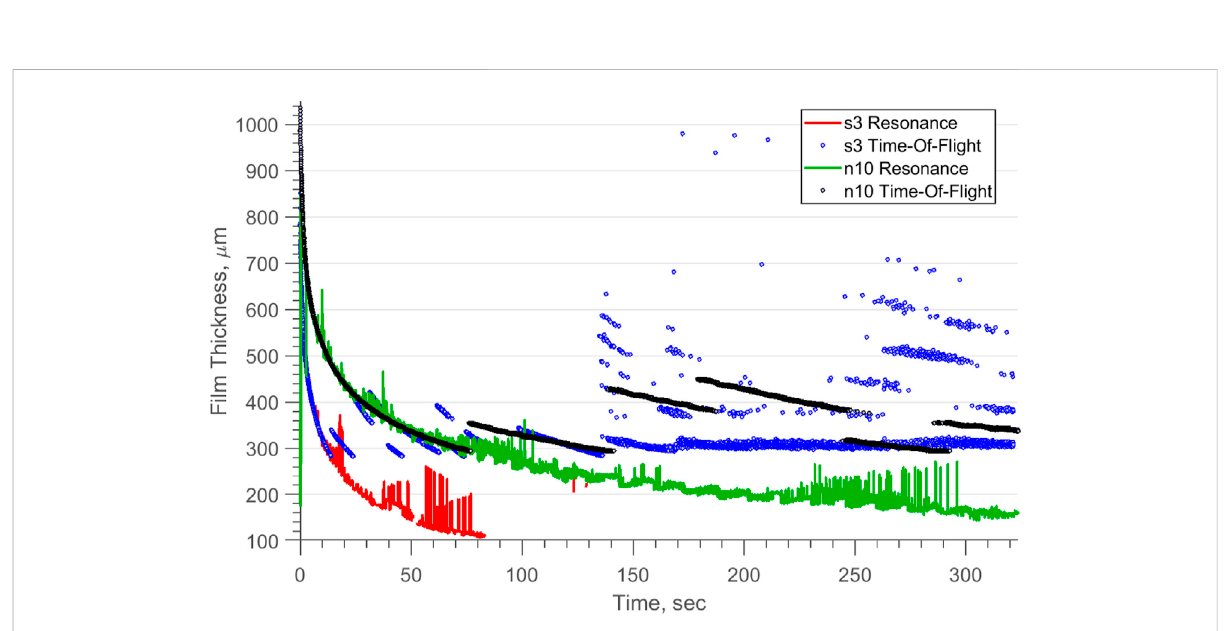
FIGURE 9 Film thickness of thinning oil drops measured by time-of- fl ight and resonance